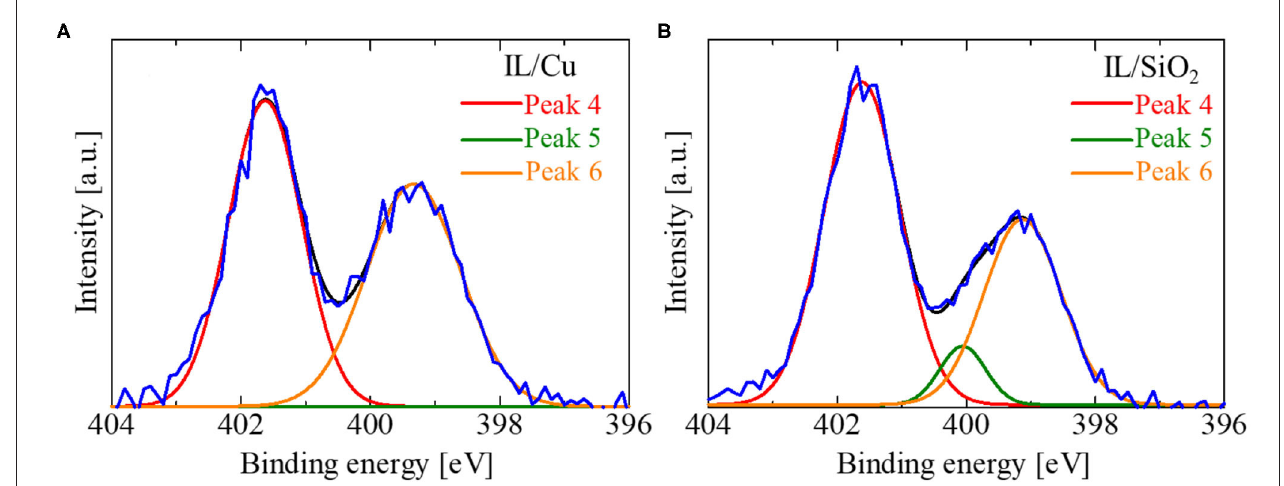
FIGURE 7 | Waveform analysis for N 1s XPS spectrum in (A) IL/Cu and (B) IL/SiO 2 . Red, green, and orange curves are the fitting results for peak separation and black curves are the summation of those curves. For IL/Cu in (A) , the peak intensity for Peak 5 was zero.